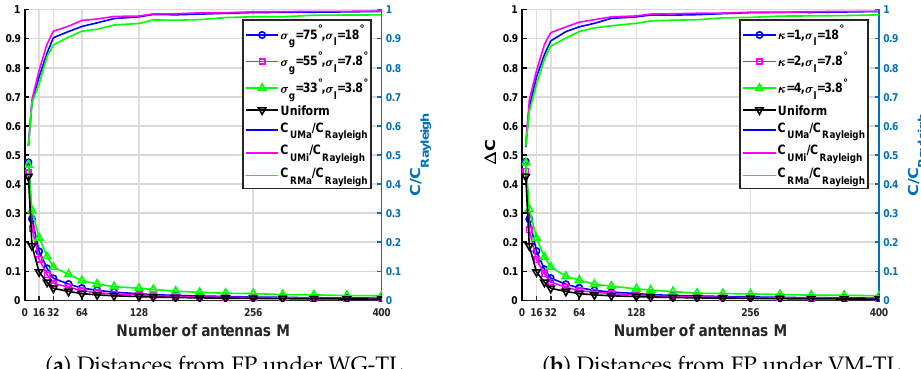
Figure 8. The distance from FP against the antenna number M , angle spread σ and concentration factor κ under WG-TL and VM-TL.